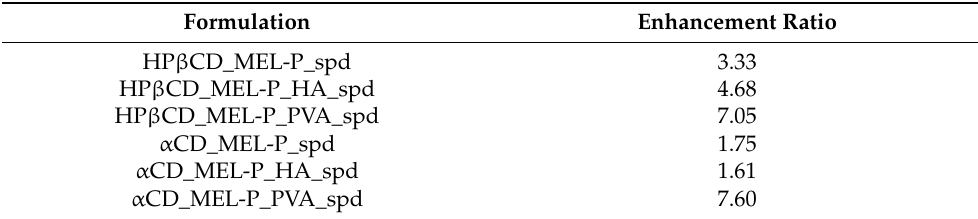
Figure 8. Flux of the spray dried samples at 15 min. Table 3. Enhancement ratios.